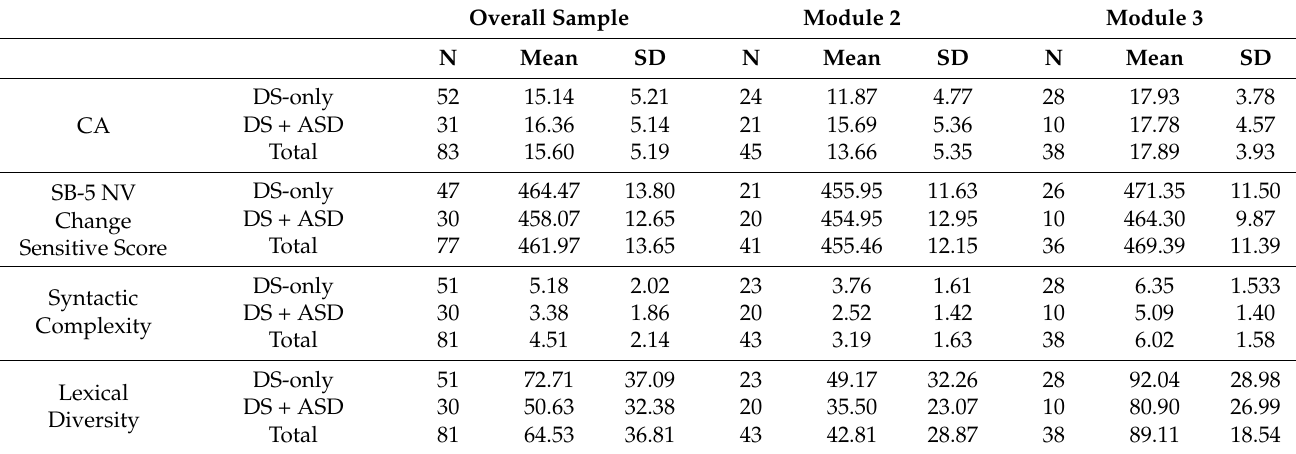
Table 2. Means for Participants Characteristics for overall sample, Module 2 and Module